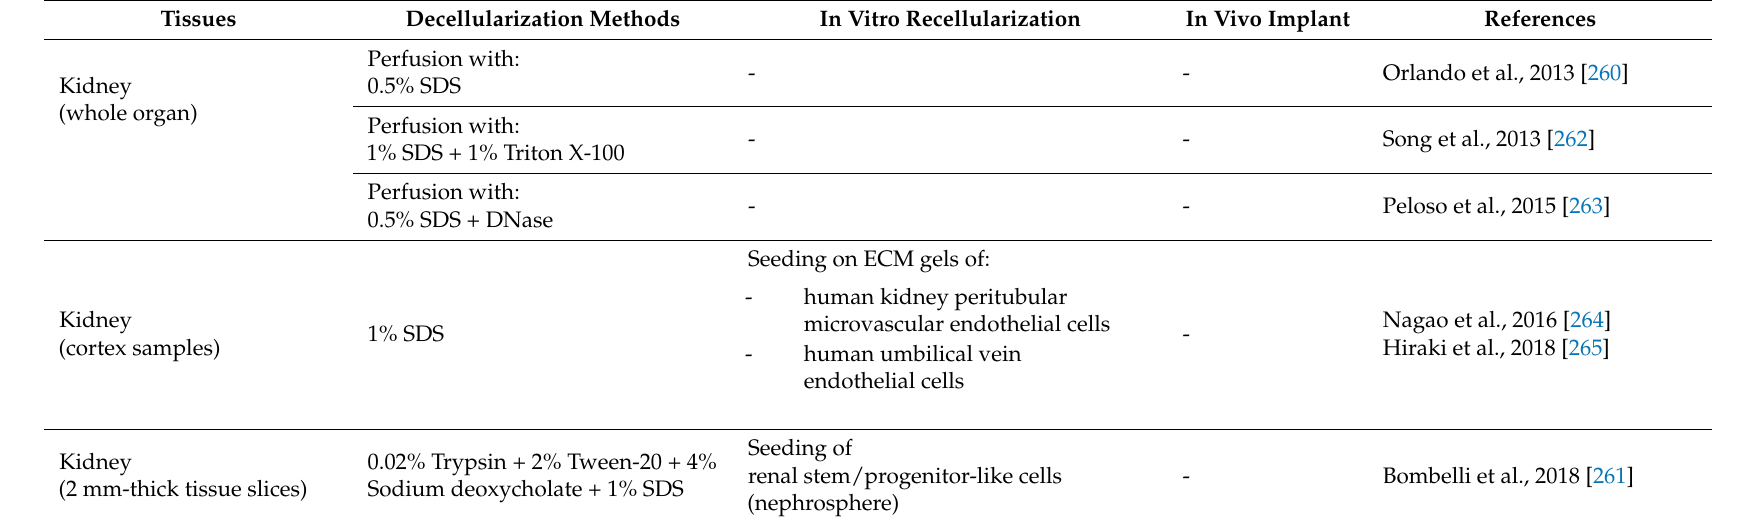
Table 9. Kidney. Decellularization techniques, recellularization methods, and in vivo implant of human renal extracellular